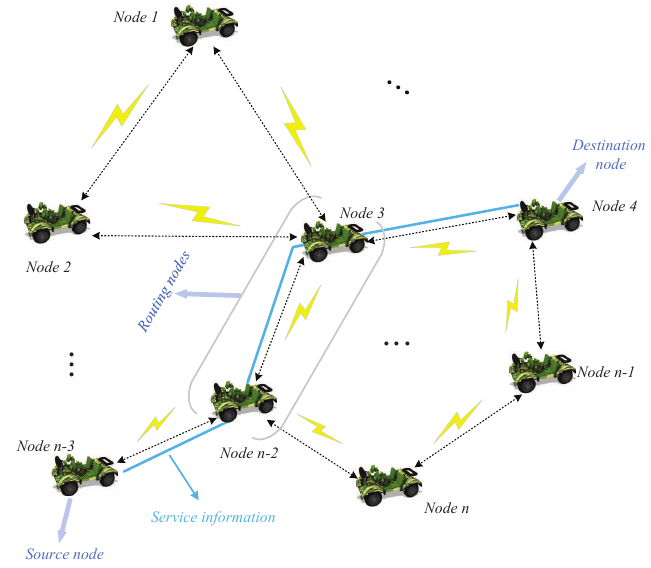
Figure 1. The application scenario of tactical unmanned vehicle sensing system